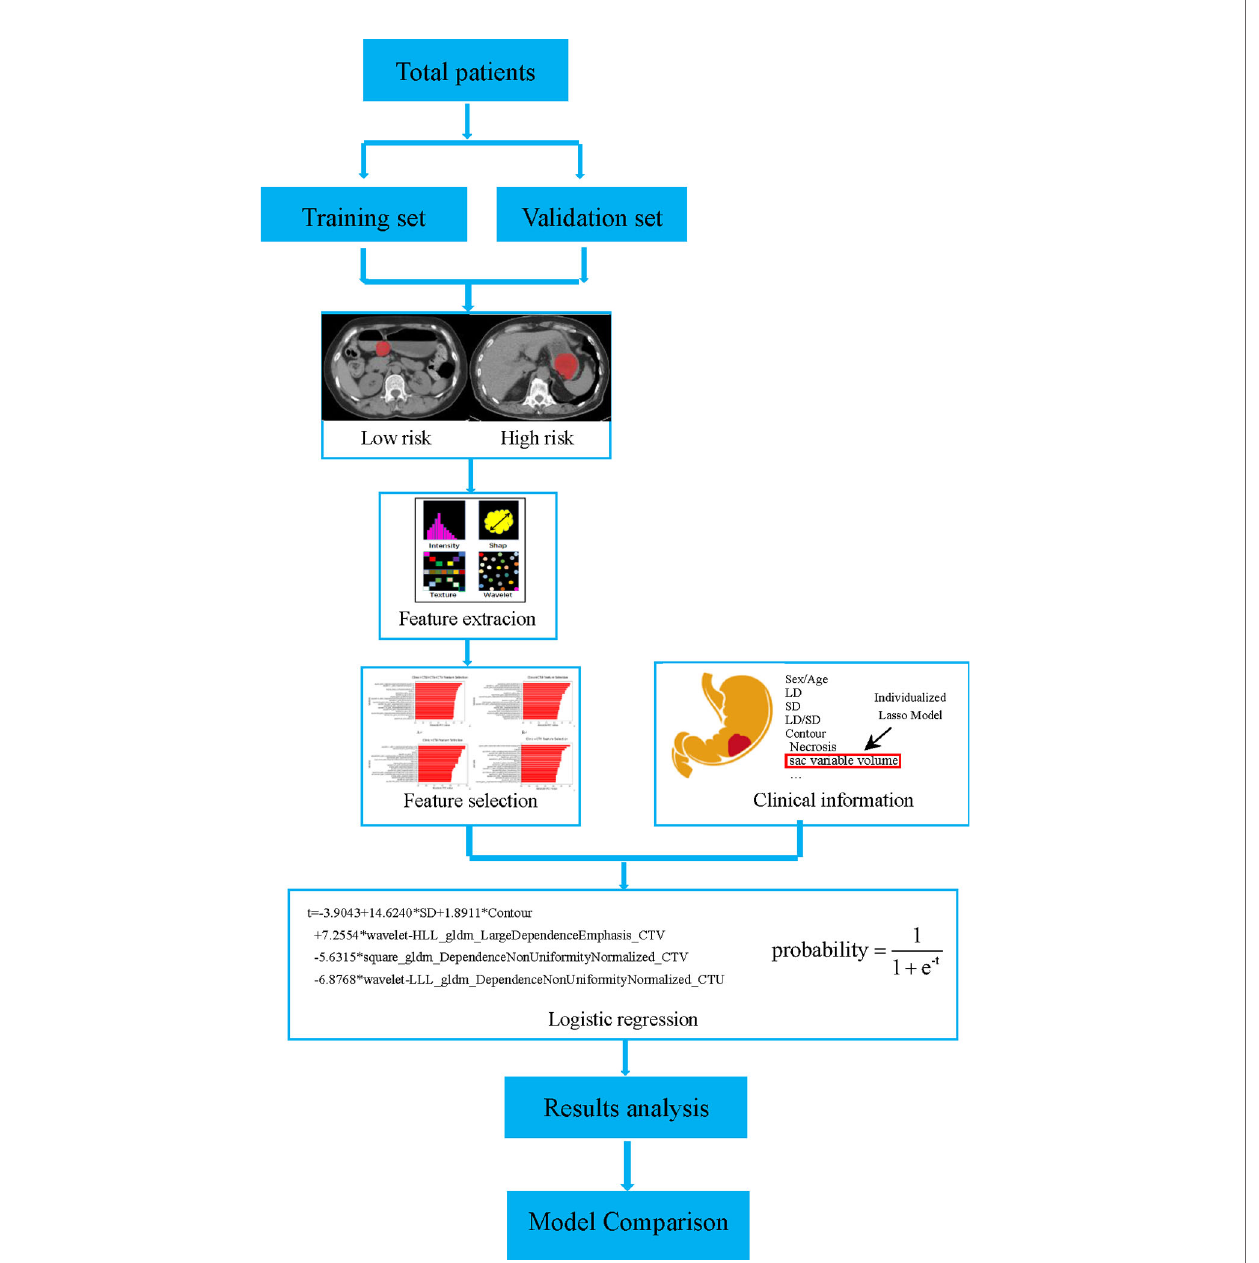
FIGURE 2 | Flow chart of the proposed work fl ow. GISTs were divided into a training set and a validation set. According to the NIH criteria, the lesion segmentation and features extraction were performed. The radiomics models were built based on CT images combining clinical information, and a comparison between models was also